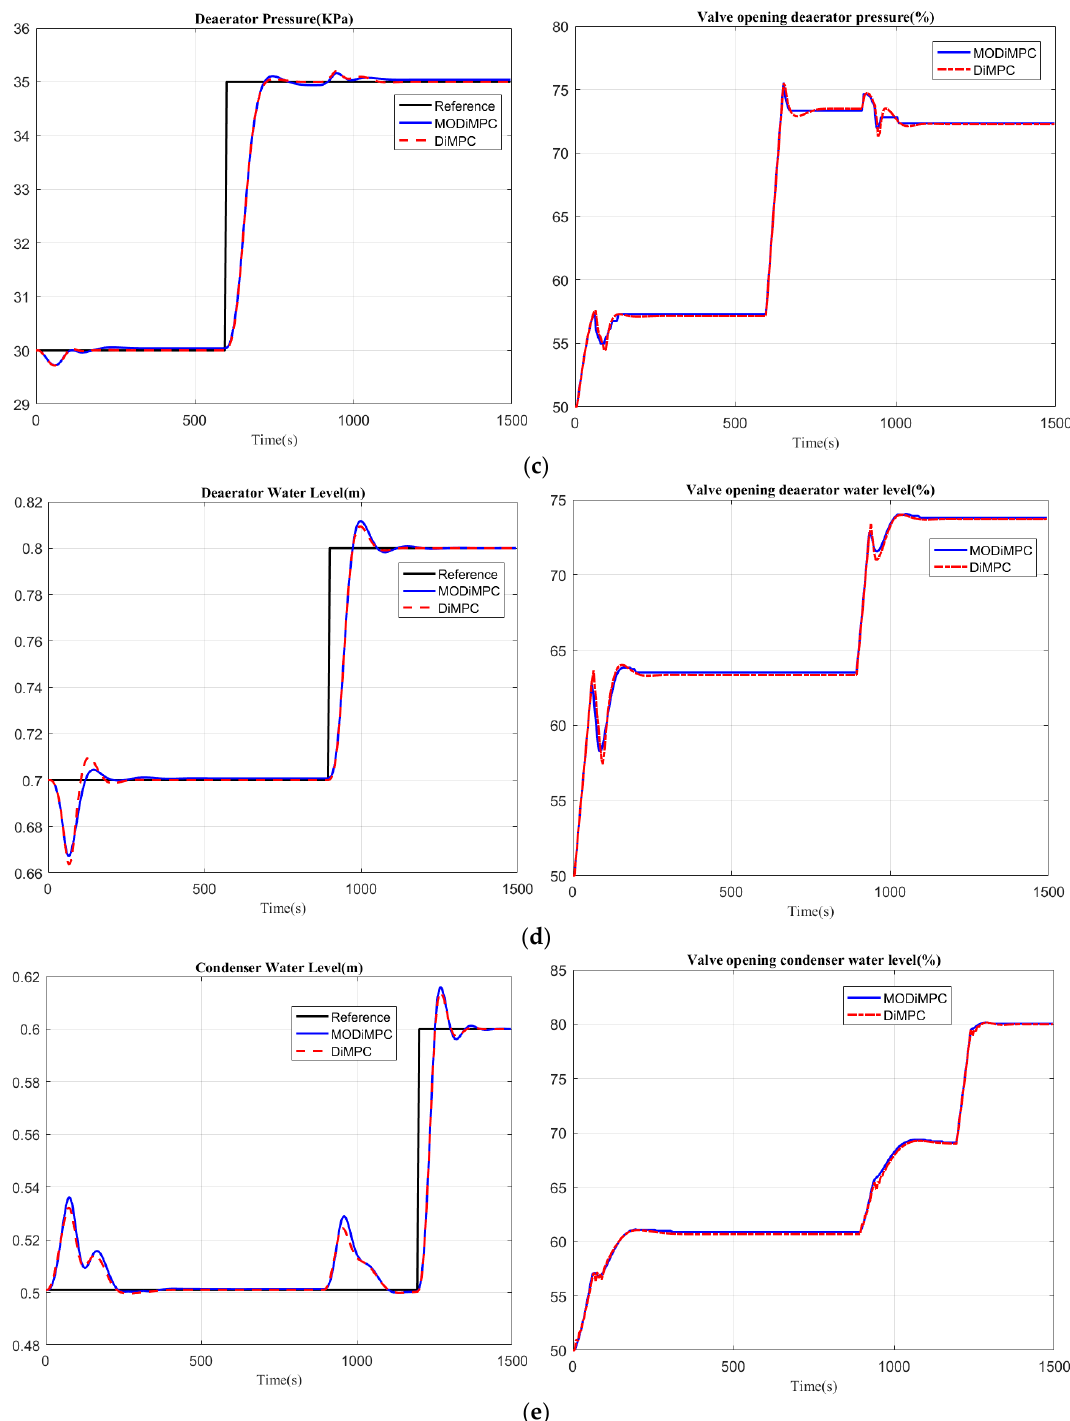
Figure 10. The responses of the steam/water loop under the MODiMPC and DiMPC for ( a ) drum water level control loop, ( b ) deaerator water level control loop, ( c ) deaerator pressure control loop, ( d ) condenser water level control loop and ( e ) exhaust manifold pressure control loop (The figures on left hand indicate the outputs, and on the right hand indicate the inputs).